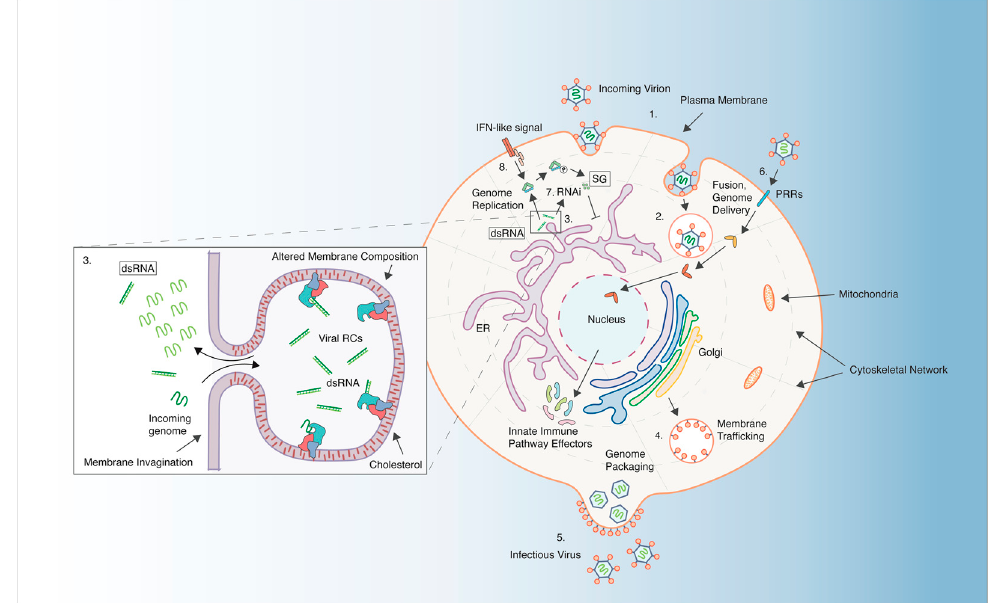
Figure 2. Overview of RNA virus replication in an arthropod cell. 1. Incoming virus particle enters the cell following receptor-mediated endocytosis; 2. Viral genome is delivered into the cytoplasm after the internalized virion escapes the endosome, either by pore-formation or after undergoing fusion with the endosomal membrane; 3. Genome replication occurs inside cytoplasmic virus cores (dsRNA viruses) or within modified membrane-associated structures (see inset) containing virus-encoded replication complexes (RCs). Double-stranded viral RNA (dsRNA) is synthesized as a replication intermediate; 4. After synthesis of viral structural proteins, some are trafficked to the plasma membrane while core proteins encapsulate newly synthesized viral RNA to form cytoplasmic cores; 5. Some viruses obtain their envelope at the plasma membrane before exiting from the cell while others exit following lysis. Presence of virus in the cell also elicits different antiviral responses; 6.